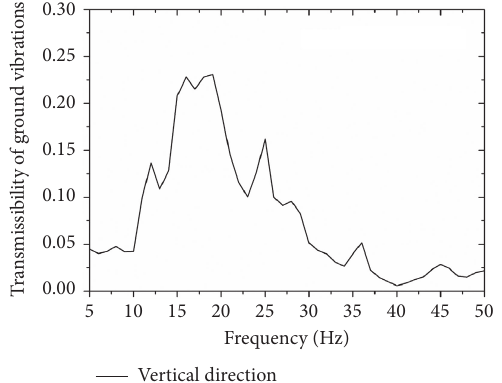
Figure 15: Transmissibility of ground vibrations transmitted from the vibration source area to the high-tech lab